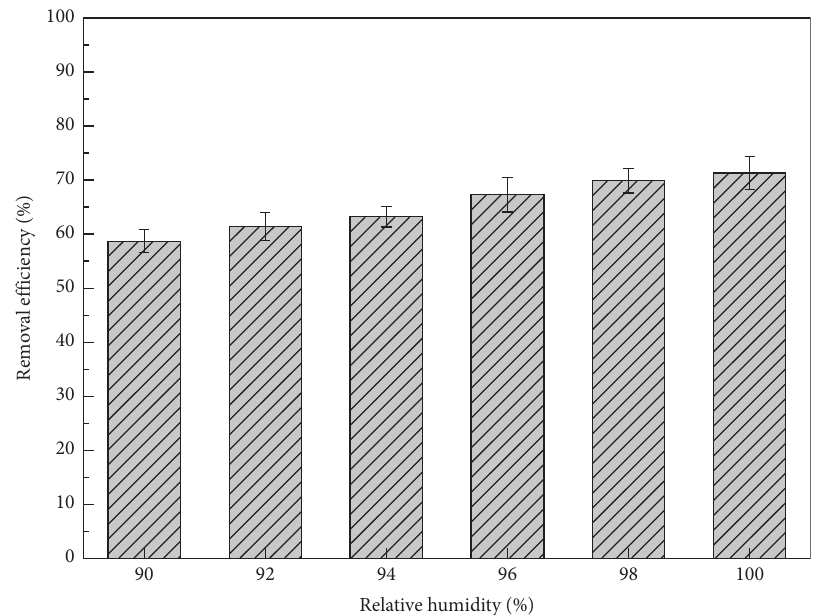
Figure 8: Effect of relative humidity on the removal efficiency of sulfuric acid